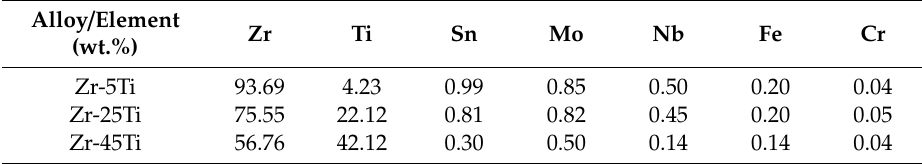
Table 1. Chemical composition of the binary Zr-Ti alloys under